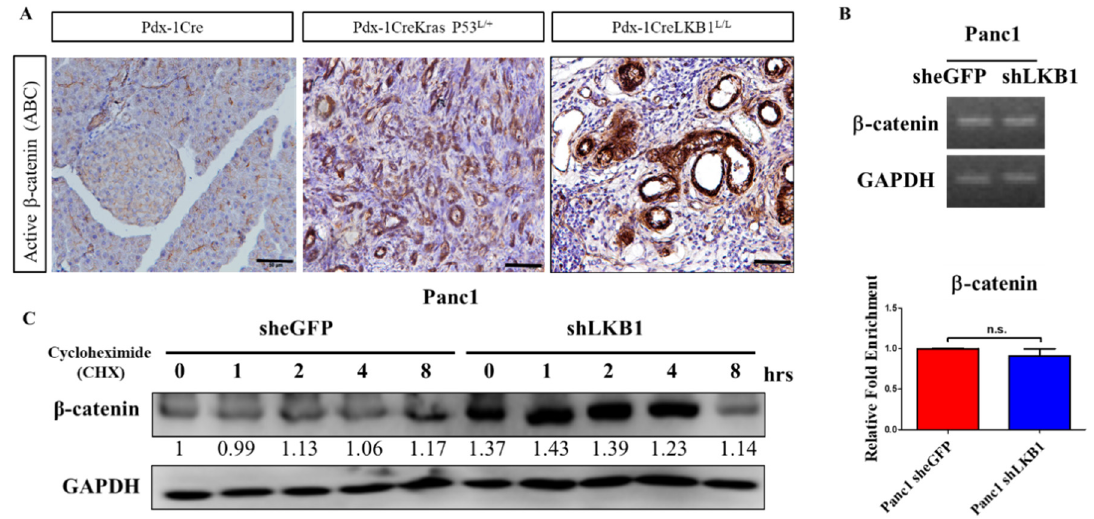
Figure 2. LKB1 loss stimulates the Wnt/ β -catenin pathway and enhances the stability of β -catenin in pancreatic cancer (PC). ( A ). Immunostaining demonstrated that active β -catenin (ABC) staining was more intense during pancreatic carcinogenesis. The activation of β -catenin was assessed by immunohistochemistry for ABC in paraffin-embedded pancreas sections of Pdx-1Cre, Pdx-1 Kras P53 L/+ , and Pdx-1CreLKB1 L/L mice. Scale bar is 100 µm. ( B ). QRT-PCR analysis of β -catenin in Panc-1 shLKB1 and eGFP control cells. To confirm the mRNA expression levels of β − catenin in Panc-1 shLKB1 and Panc-1 sheGFP control cells, we used reverse real-time PCR. Gel electrophoresis of PCR products by RT-PCR amplification of β -catenin and the GAPDH gene. We found no significant difference of β -catenin gene expression in Panc-1 shLKB1 and sheGFP control cells. The bottom panel shows a quantitative analysis of β -catenin mRNA levels by real-time RT-PCR in Panc-1 shLKB1 and she GFP control cells. n.s. means no statistical significance. ( C ). Western blotting analysis revealed that the knockdown of LKB1 enhanced the stability of β -catenin in Panc-1 cells. Cells were pretreated with cycloheximide (CHX) (50 µM) and incubated for various periods of time and endogenous β -catenin protein expression was detected by Western blot analysis with an anti- β -catenin antibody. GAPDH served as a loading control. Relative densitometric values are provided below the blot images. The results are shown for one of three independent experiments.